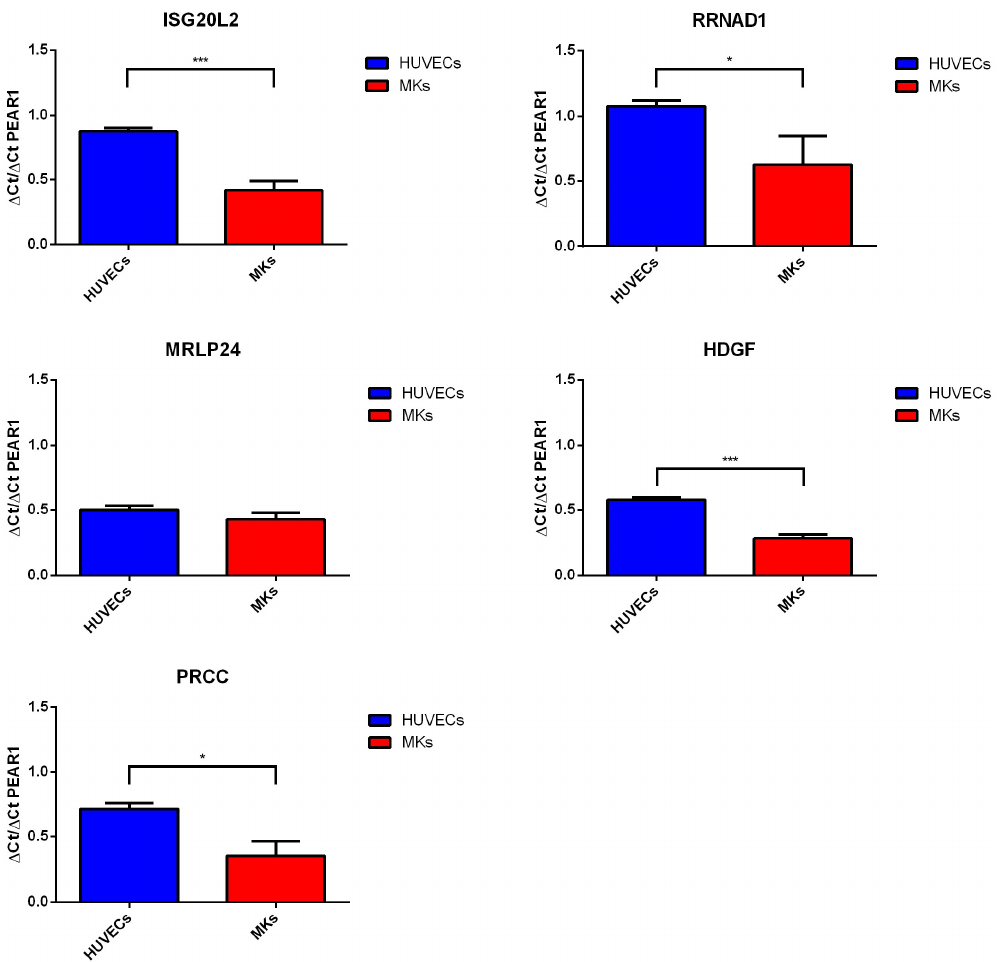
Figure 6. PEAR1 interacting gene expression. ISG20L2 , RRNAD1 , MRLP24 , HDGF , PRCC and PEAR1 expression via quantitative RT-PCR in HUVECs and MK precursors (day 14) from at least 3 biological replicates (mean +/− SD). For each gene data are expressed as “fold” increase relative to GAPDH expression and presented as ratio vs. PEAR1-GAPDH ∆Ct. * p -value < 0.05, *** p -value < 0.0001, unpaired t -test. Details on assays used are reported in Materials and Methods.